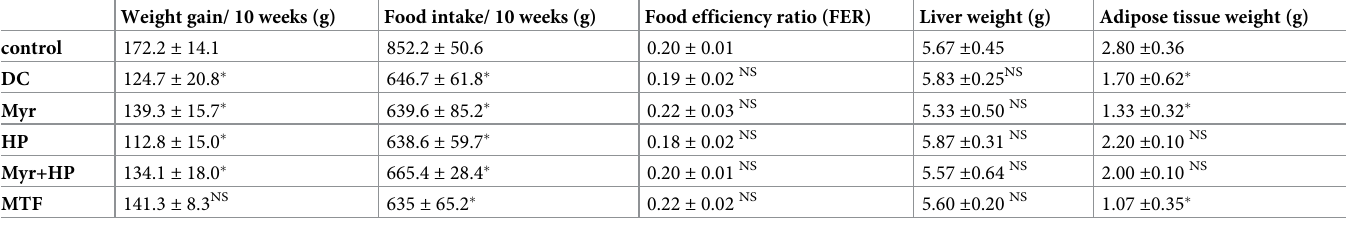
Table 1. Growth parameters of experimental rats. Weight gain/ 10 weeks